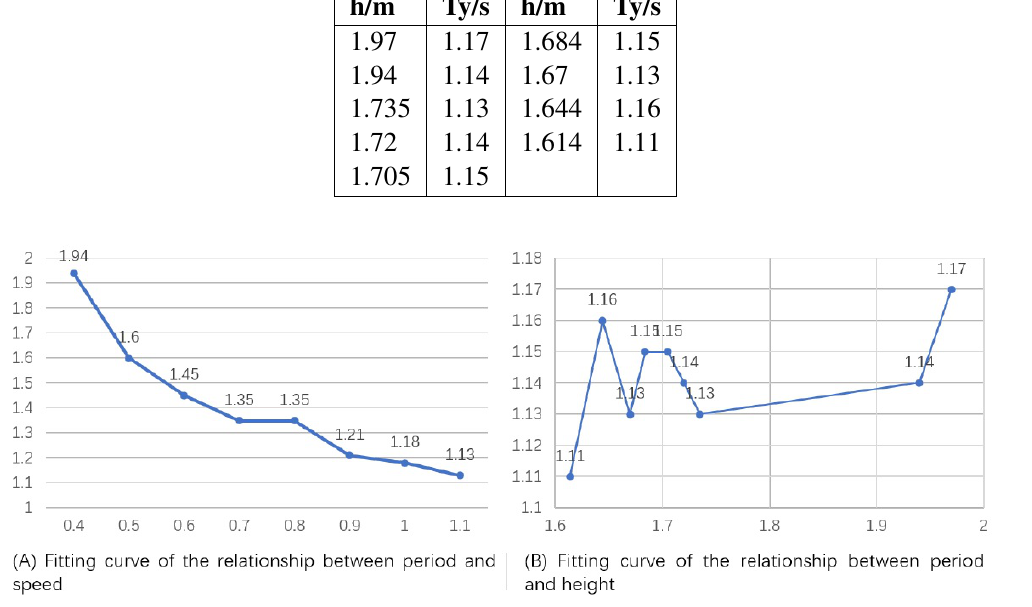
Fig. 5 Fitting curve of the relationship between period and speed and